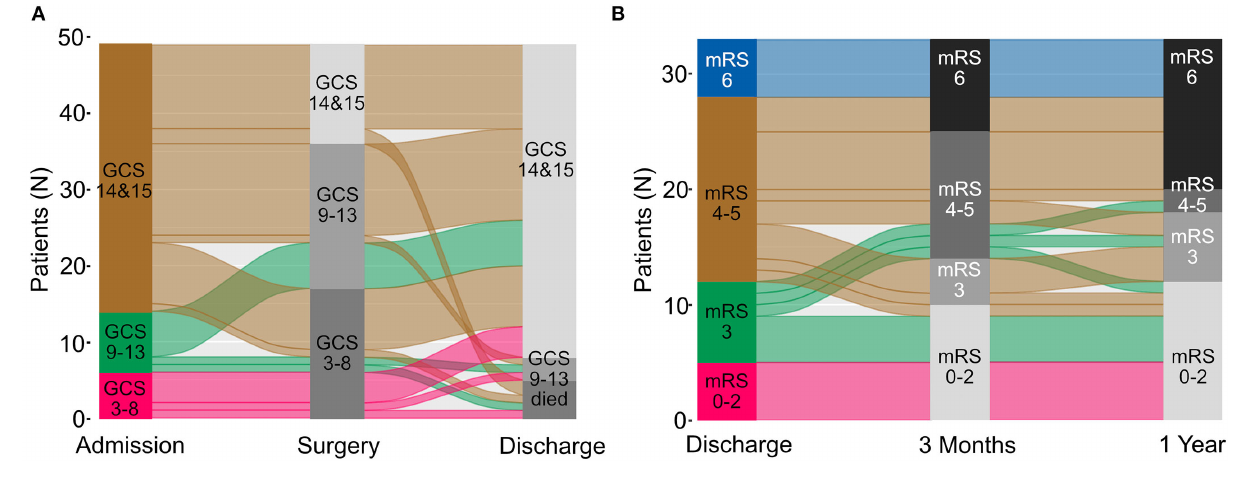
FIGURE 2 | Migration plot of functional status changes from admission to discharge and during follow-up are shown as a. In (A) GCS scores at admission, before surgery, and at discharge are displayed for all patients. In panel (B) mRS scores at discharge, at 3 months and 1 year after surgery are shown in n = 33 patients for whom complete data were available. GCS, Glasgow Coma Scale; mRS, modified Rankin